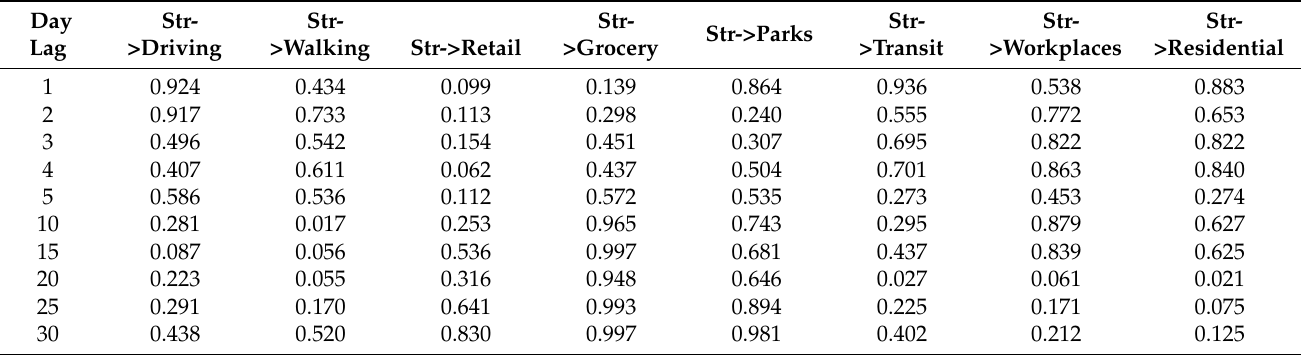
Table A5. Stringency_index (Str), Granger-cause mobility variables, and p -values in day lags in Poland.